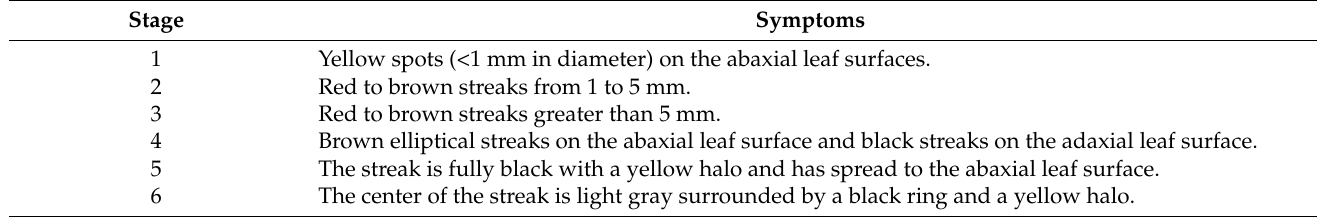
Table 1. Severity scale of banana leaves affected by black sigatoka disease (BLSD).